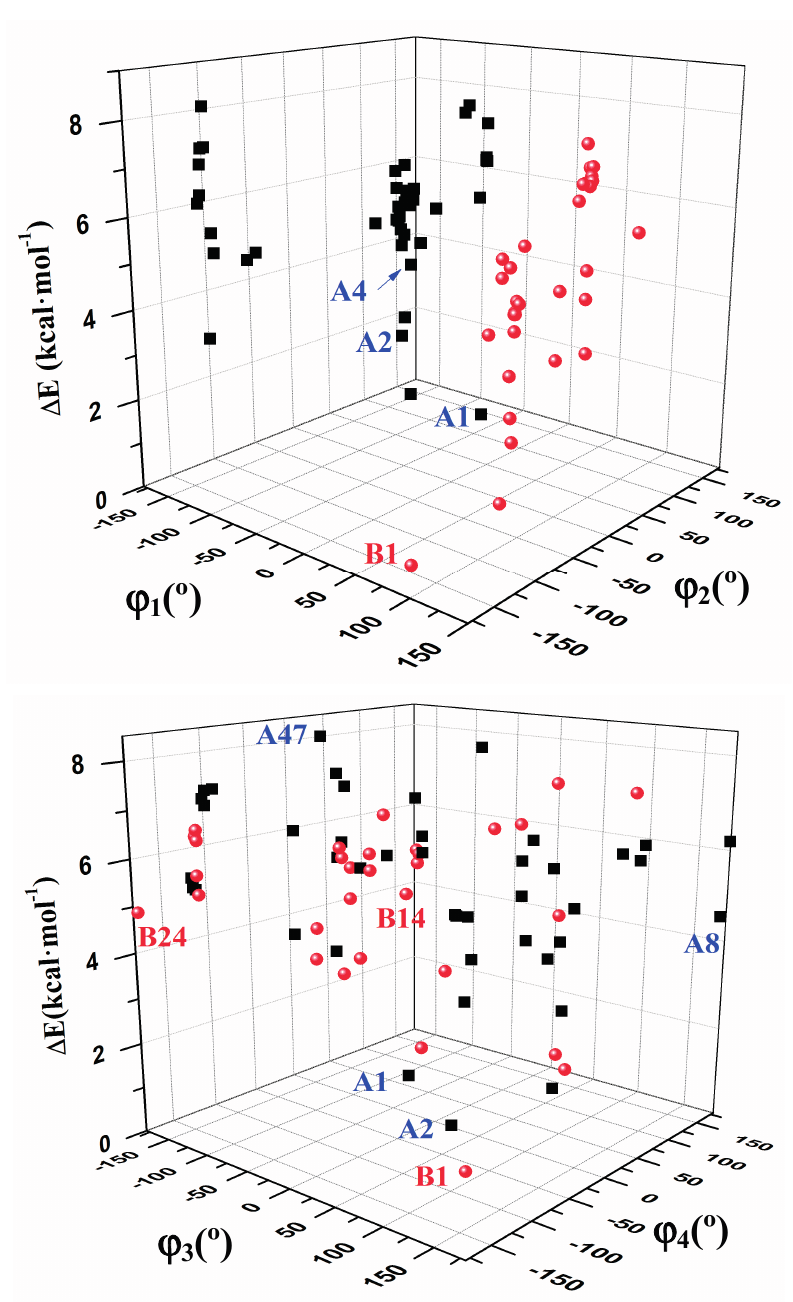
Figure 9. 3D plots with the relative energies of the 78 optimum stable conformers according to the values of the exocyclic torsional angles: φ electronic energy Δ E +